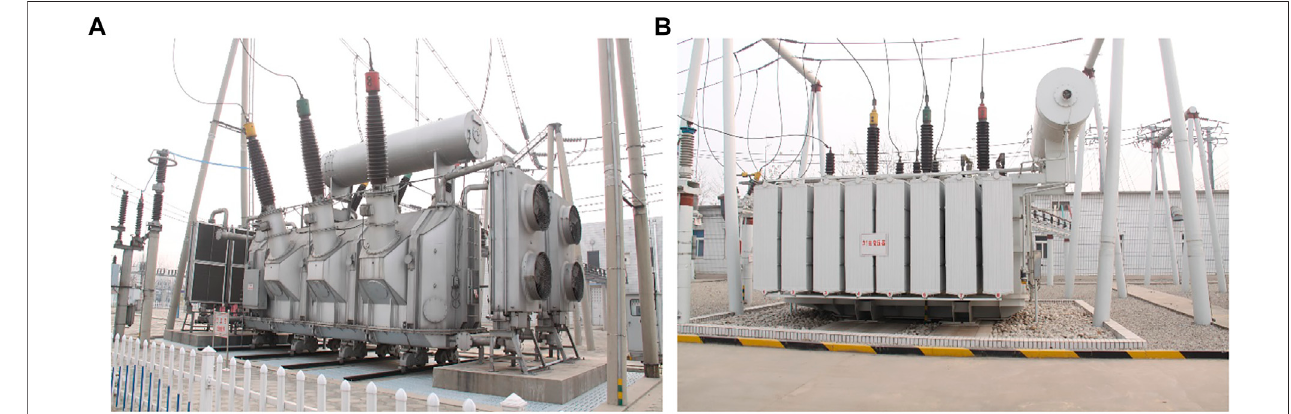
FIGURE 6 | (A,B) Two transformer images in transformer detection data set.